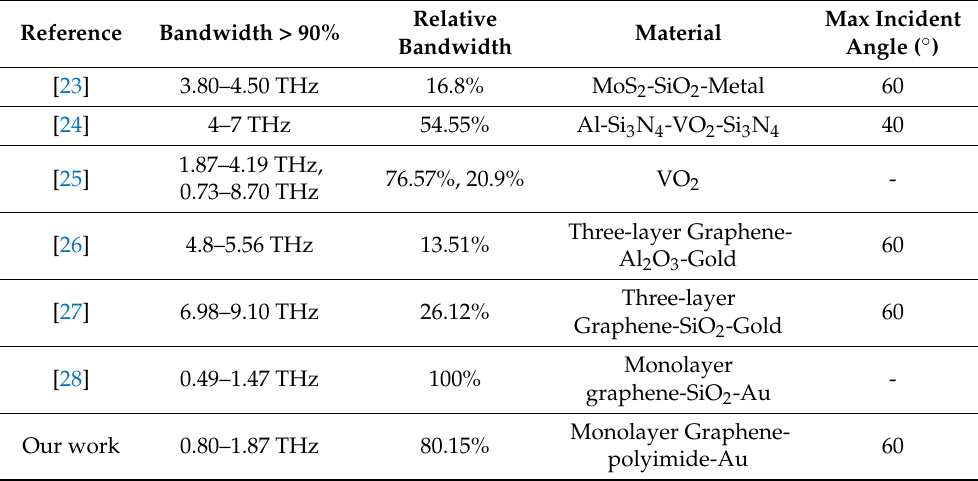
Table 2. Comparison with the published terahertz